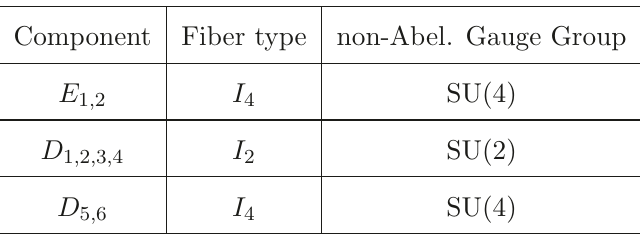
Table 3 . Singular fiber types and the corresponding gauge groups on the discriminant components of a complete intersection